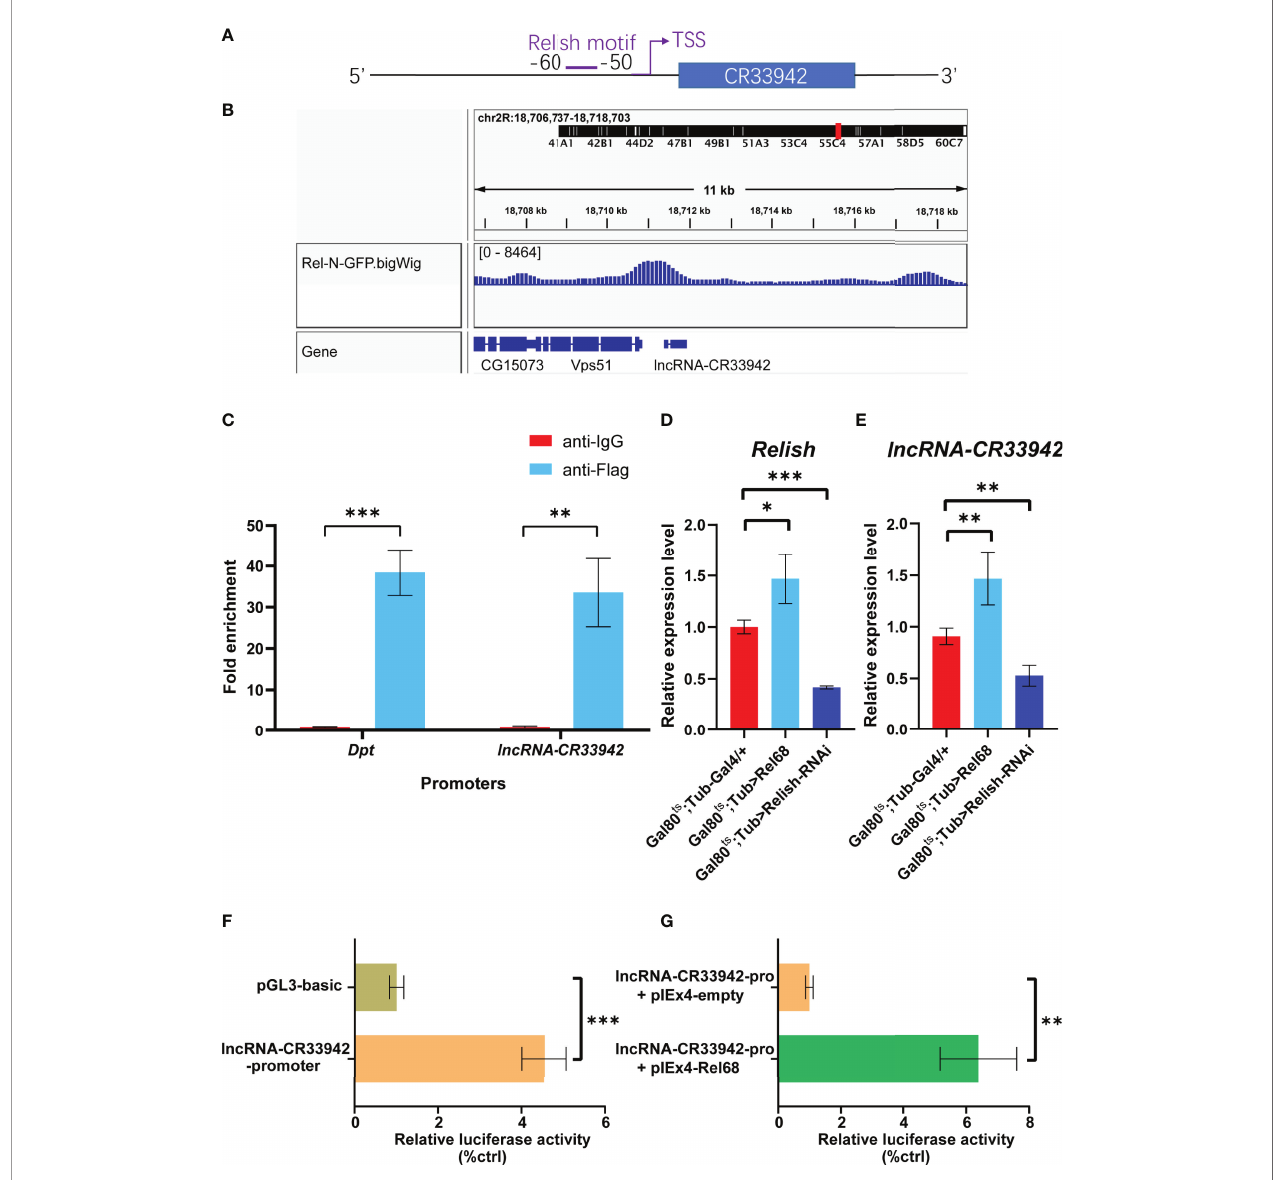
FIGURE 4 | Relish directly activates the transcription of lncRNA-CR33942 . (A) Schematic diagram of Relish motif in the lncRNA-CR33942 promoter region. (B) ChIP-seq visualization of Rel-N-GFP using IGV. (C) ChIP-qPCR was performed in Flag-Rel68 overexpressing S2 cells normalized to control expression levels. The expression levels of Relish (D) and lncRNA-CR33942 (E) in Rel68 overexpressing and Rel68-RNAi fl ies. (F, G) The dual-luciferase reporter assays were performed to detect the activity of the lncRNA-CR33942 promoter with or without Rel68 overexpression. *P < 0.05; **P < 0.01; ***P <